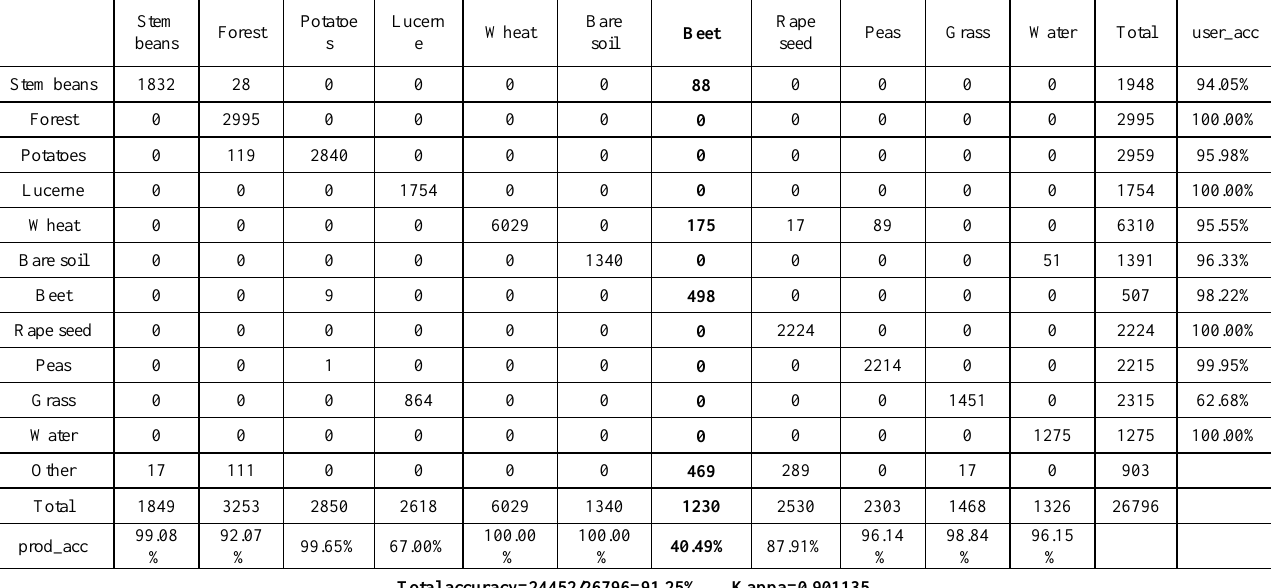
Figure 7. BPT segmentation map Figure 8. Merged classification map of Figure 9. Classification map using d SW Figure 9 Table 1. Confusion matrix of the classification result using d SRW